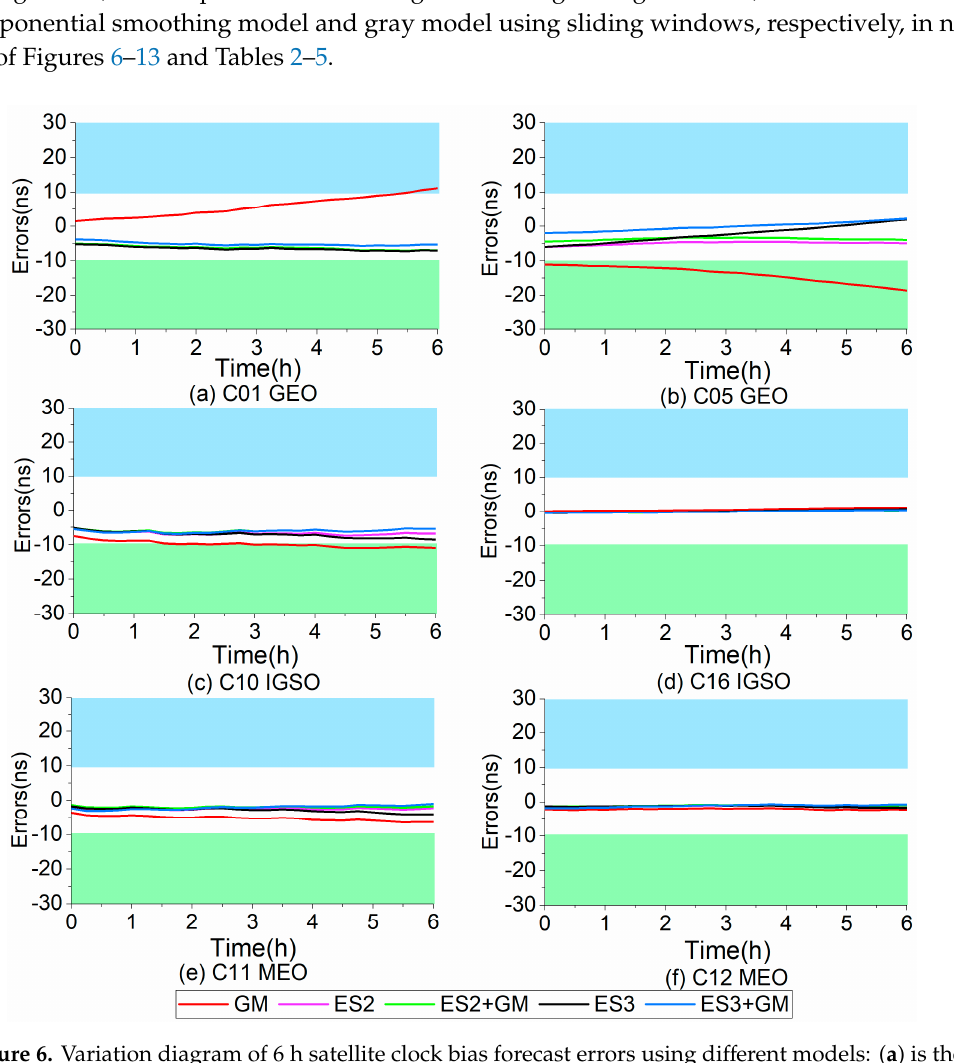
Figure 6. Variation diagram of 6 h satellite clock bias forecast errors using different models: ( a ) is the changes of the C 01 SCBs forecast, ( b ) is the changes of the C 05 SCBs forecast, ( c ) is the changes of the C 10 SCBs forecast; ( d ) is the changes of the C 16 SCBs forecast, ( e ) is the changes of the C 11 SCBs forecast, and ( f ) is the changes of the C 12 SCBs forecast.